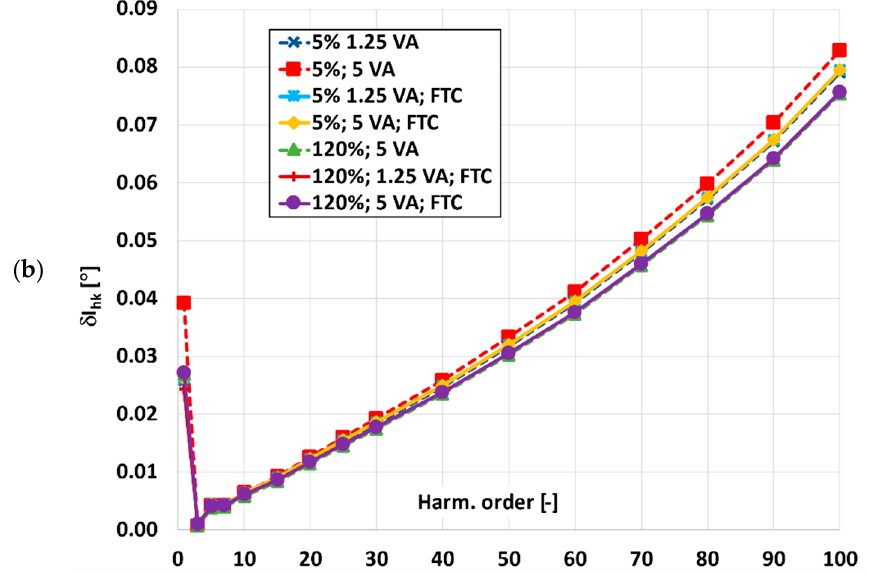
Figure 9. Influence of the applied fractional turn correction of the secondary winding of the TCT on the values of ( a ) current error and ( b ) phase displacement (abbreviation: FTC—fractional turn cor- rection).